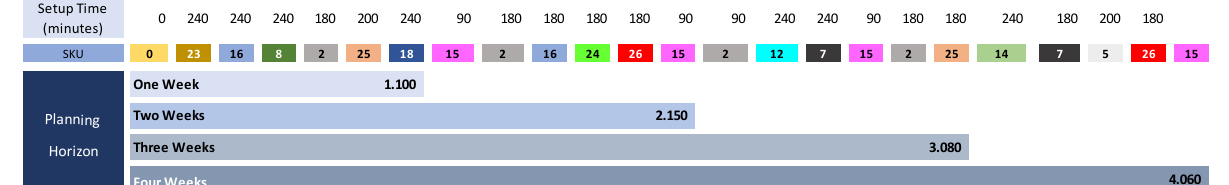
Figure 3. Measurement of setup time–machine seven from loop dye group, 13 SKU.